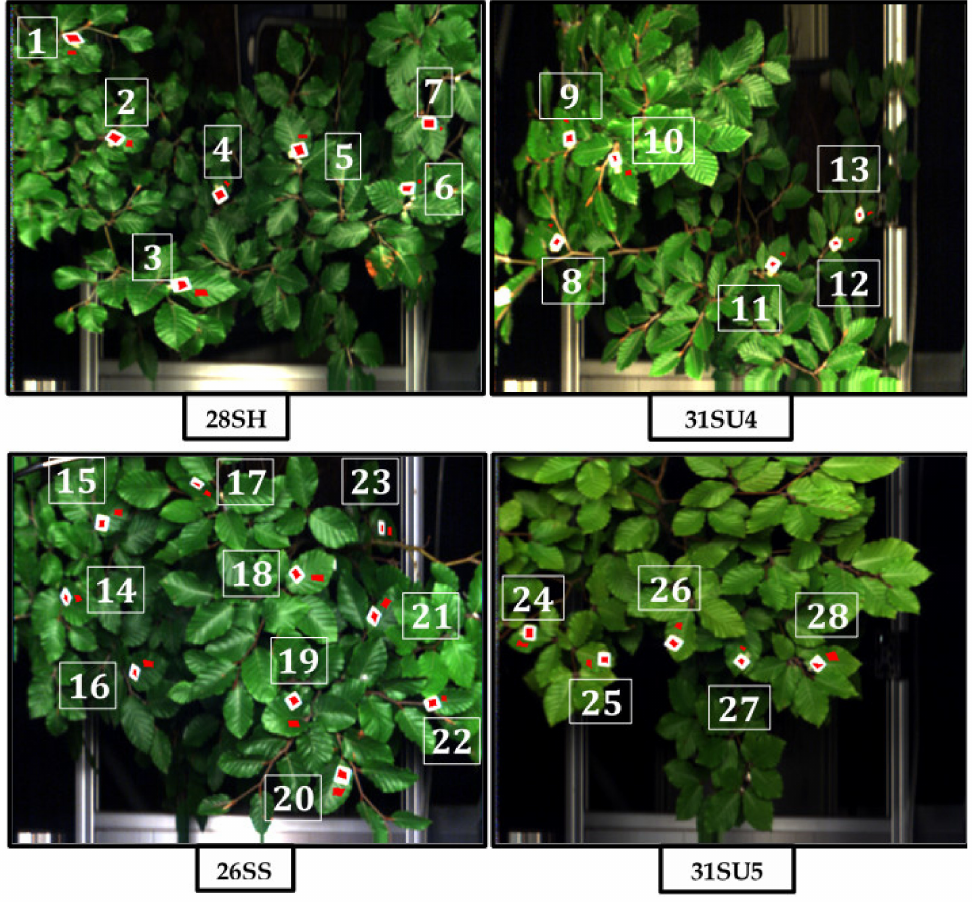
Figure 4. Color images of several beech canopies with numbered at-target white references in the top of canopy view. In red color the ROIs of both the leaf surface and TW surface used for the calculation of R Leaf-T are